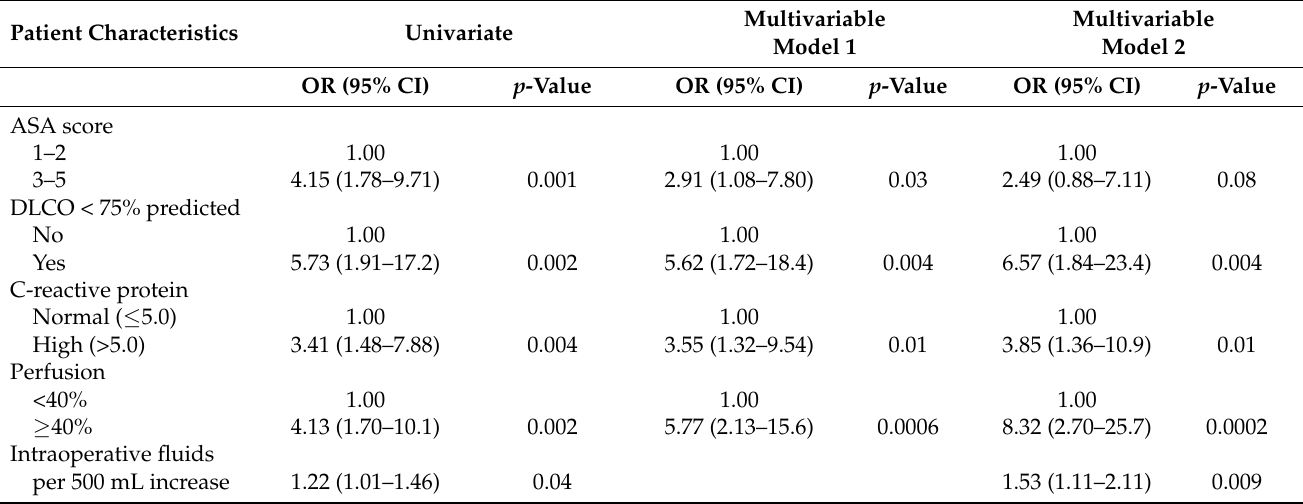
Table 4. Preoperative (model 1) plus perioperative (model 2) predictors of ARDS in univariate and multivariable analyses.